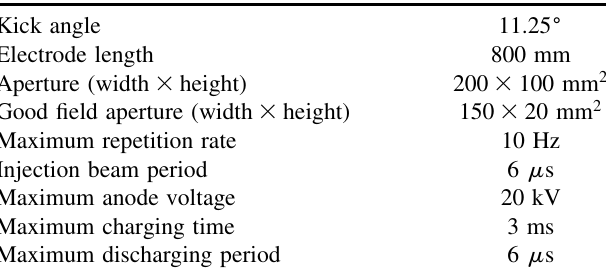
TABLE I. Parameters of the